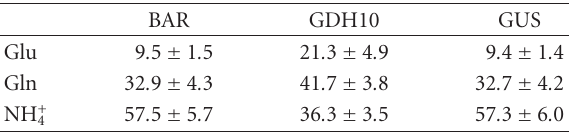
Table 1. Labeling of the glutamate pool via absorption of 13 NH + 4 in intact roots of transgenic plants not treated with 1mM MSX. Tracer exposure was for 15 minutes. Incorporation is expressed as a percentage of the label input plus or minus the range de- tected among 3 individual plant replicates and three measure- ment replicates.